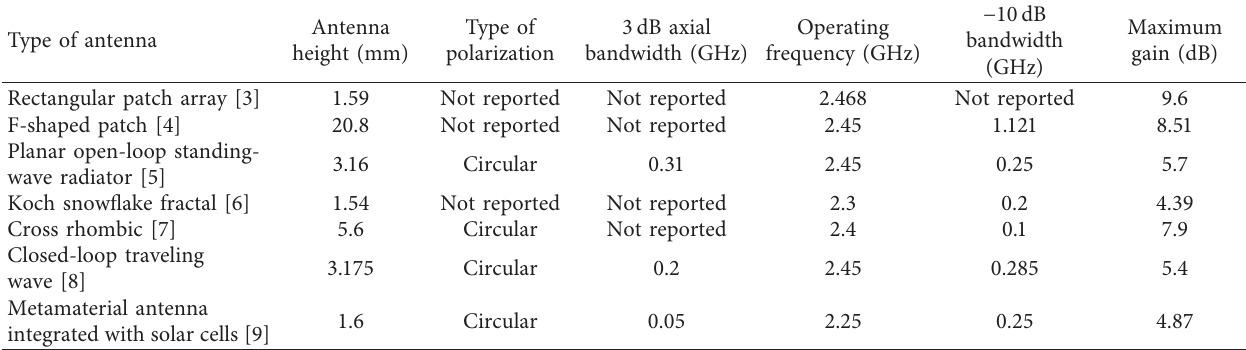
Table 1: Some S-band planar antennas for